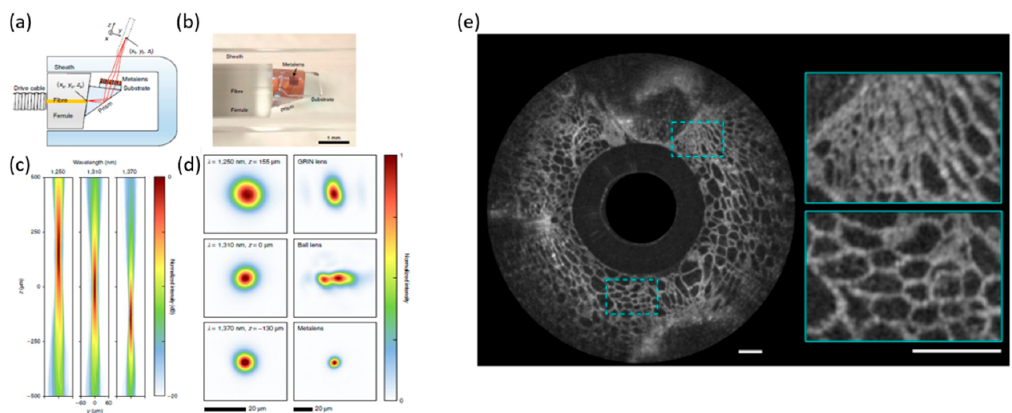
Figure 12. Metalens-based endoscopic optical coherence tomography ( a ) Schematic of the nano-optic endoscope. ( b ) Photographic image of the distal end of nano-optic endoscope. ( c ) Measured intensity distribution of the output beam of the nano-optic endoscope along the propagation direction in the yz -plane at λ = 1250, 1310 and 1370 nm. ( d ) ( left ) Focal spot profiles of the nano-optic endoscope at corresponding wavelengths. ( d ) ( right ) Focal spot profiles of a graded-index (GRIN) OCT catheter, a ball lens OCT catheter and the nano-optic endoscope at 1310 nm wavelength. ( e ) OCT images of fruit flesh (grape) obtained using a nano-optical endoscope. (Reproduced from [78] with permission.)